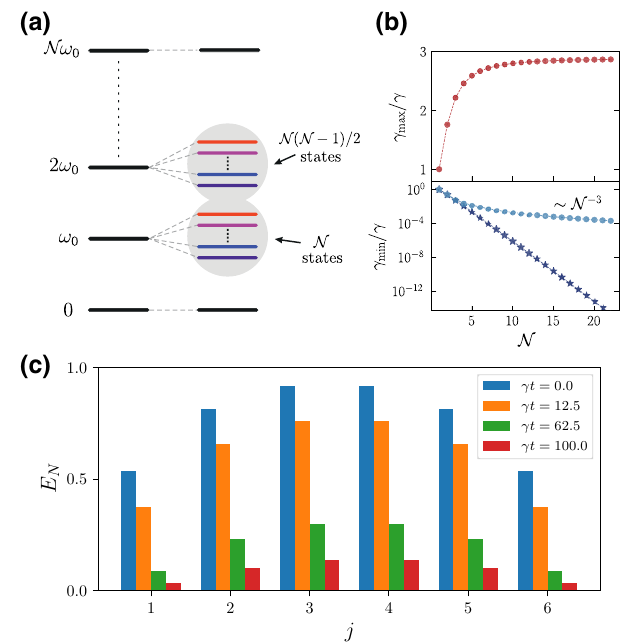
FIG. 3. (a) Energy scheme of the collective N -emitter sys- -fold degeneracy of a given n -excitation manifold tem. The C N n is lifted by the dipole-dipole interactions and contains states with superradiant (red) and subradiant (blue) character. (b) Decay rates of most superradiant γ max and most subradiant state γ min for an equidistant chain with lattice constant a = λ 0 / 4 as a func- tion of N in the single-excitation manifold. The decay rate of the most subradiant state shows a scaling with N − 3 (light blue circles). From the diagonalization of the decay matrix only, one would obtain an exponential scaling of the subradiant state with N (dark blue stars). (c) Entanglement of six-emitter equidistant chain with separation a = 0.1 λ 0 , which is initialized in the most ˜| N (cid:2) ˜| . The logarithmic negativity of each subradiant state k (cid:2) = emitter with respect to the N − 1 other emitters is plotted for different points in